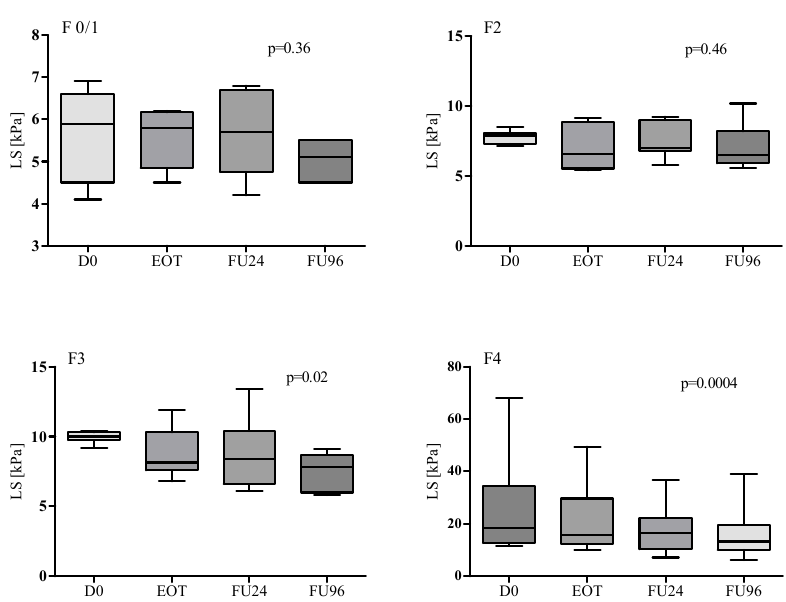
Figure 1. Reduction of liver stiffness between EOT and FU96 in individual patients. Each column represents one patient and the change in liver stiffness between end of treatment and 96 weeks later. LS—liver stiffness; kPa—kilopascal.